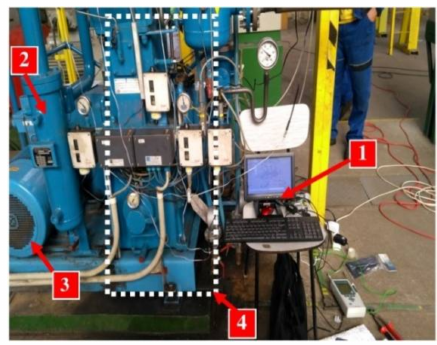
Figure 2. A view of the compressor during the experiment (1—B-Picomputer, 2—intercooler, 3—electric motor, 4—compressor